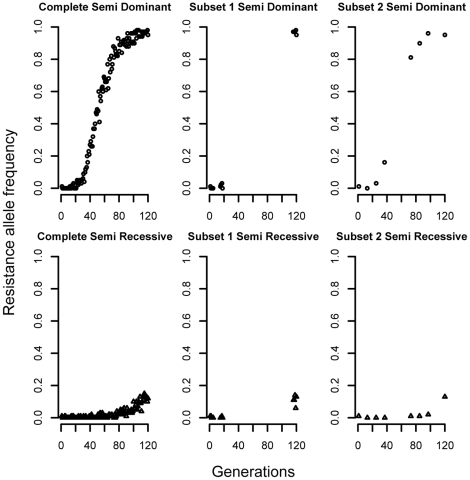
Simulated evolution of resistance allele frequency over 120 generations under two different scenarios of dominance relationship and analysing the full dataset or subsets of data.Specifications in Table 2.